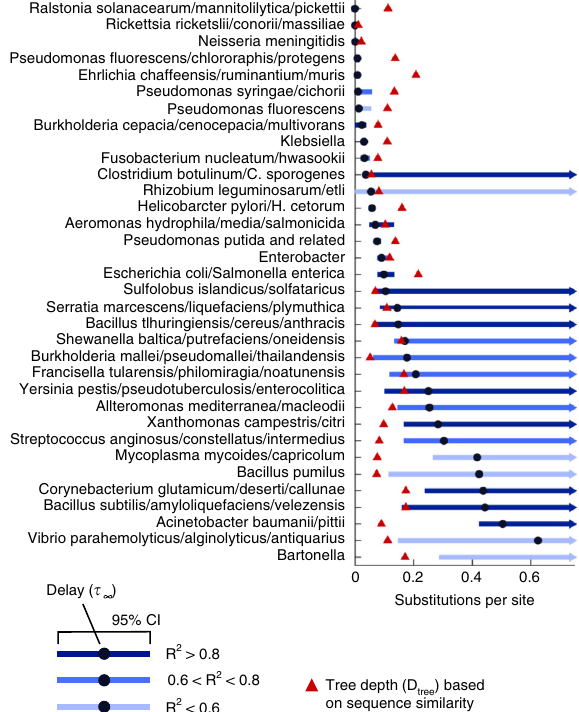
Fig. 3 Recombination-driven delay ( τ ∞ ) in the molecular clock in different groups of bacteria. Black circles indicate the best fi t of the long-term delay parameter τ ∞ based on the comparison of sequence similarity and gene content trees. Blue lines show the 95% con fi dence intervals. Red triangles indicate the total depth of the sequence similarity tree. Values of the delay above or very close to the total tree depth imply that most genomes in a group are strongly bound by homologous recombination; an upper 95% con fi dence bound cannot be calculated in those cases. Source data are provided as a Source Data fi